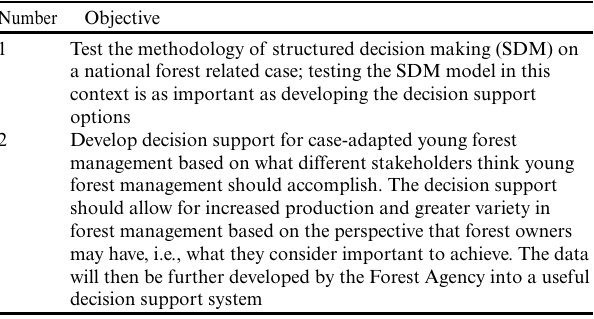
Table 3. Objectives of the collaborative